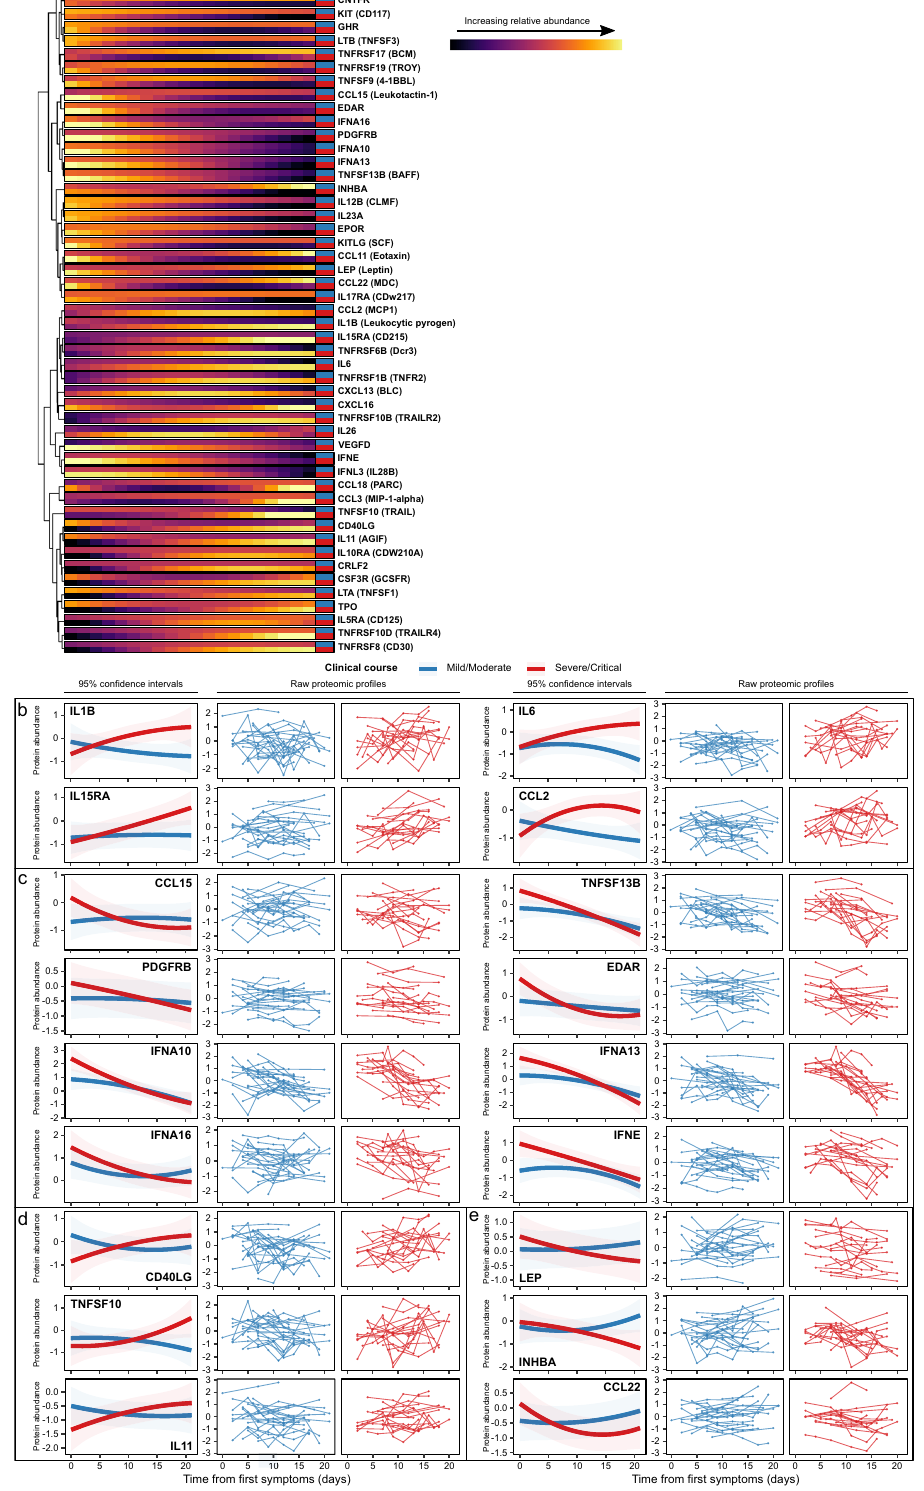
Fig. 5 | Dynamic temporal changes in circulating cytokines and receptors vary between severe and mild COVID-19. a Heatmap displaying proteins with a sig- ni fi cantly different temporal pro fi le in mild vs severe disease (TxCC, LMM, FDR<0.05). Colour indicates LMM estimated marginal means over time, strati fi ed by patient group ( n =169 samples from 40 individuals). Proteins are clustered based on the temporal pro fi le of the discordance between mild/moderate and